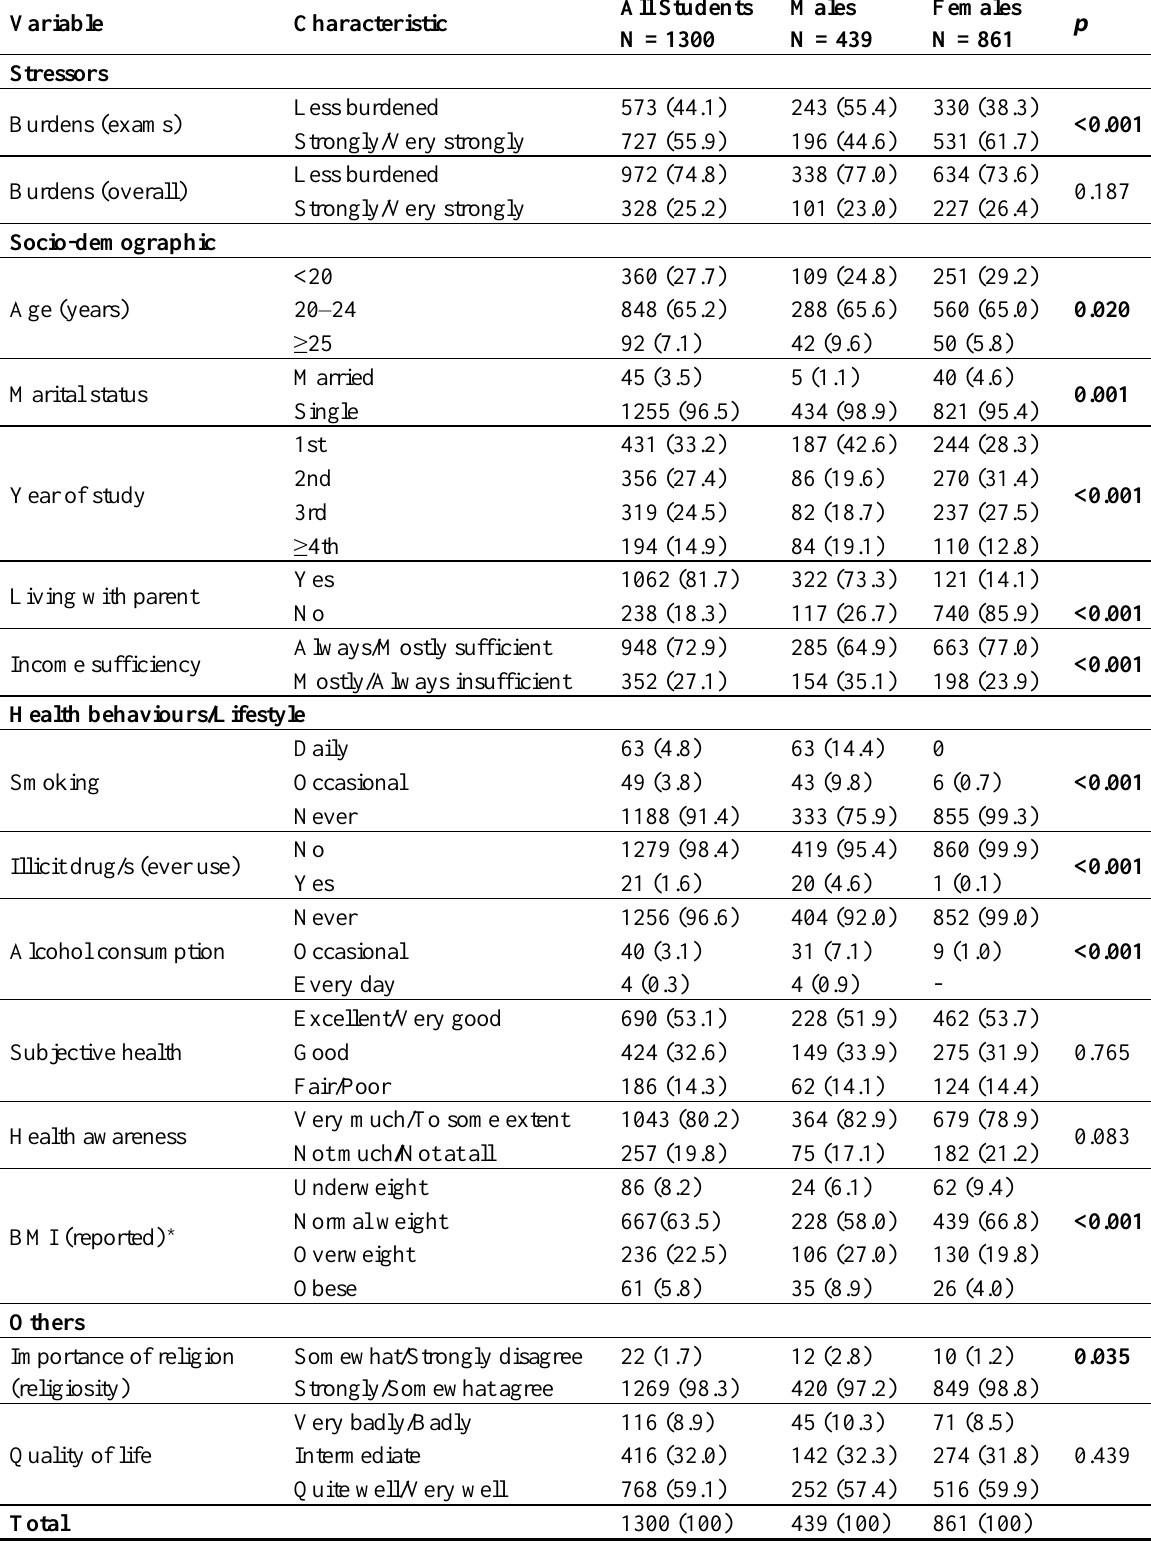
Table 1. General characteristics of the